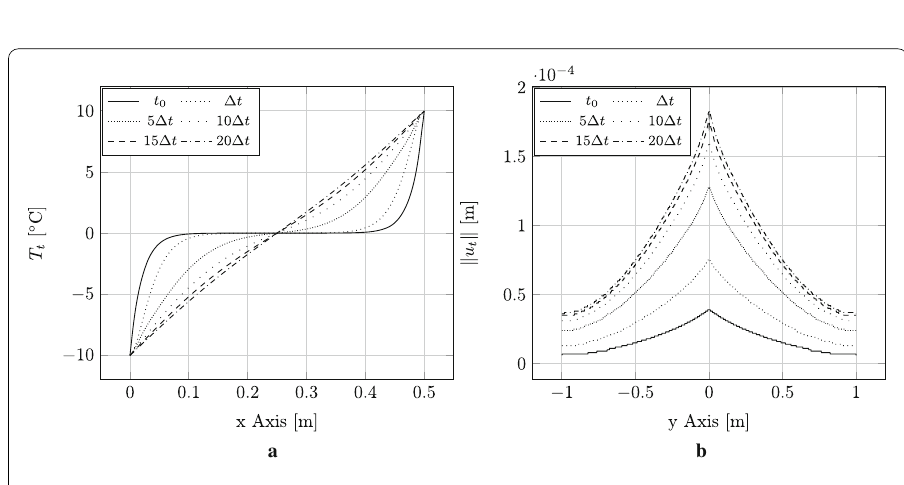
Fig. 18 Edge cracked strip under transient thermal load: a temperature field, cut over [(0,0);( 1 euclidean norm of displacement, cut over the line [( 1